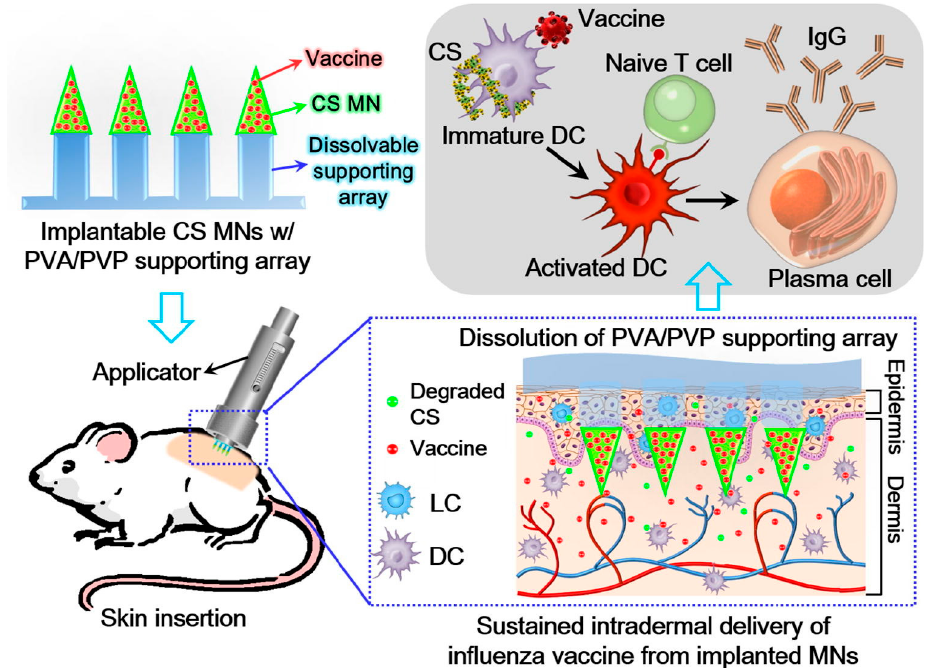
Figure 7. Schematic representation of the chitosan (CS) MNs for influenza vaccination delivery. The CS MN is easy to implant in the skin for sustained release of vaccines and immune activation [163]. Reproduced with permission from Yu-Hung Chen, Acta Biomaterialia; published by Elsevier, 2019.